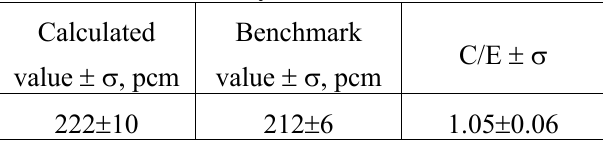
Table III. Reactivity effects of fuel circulation